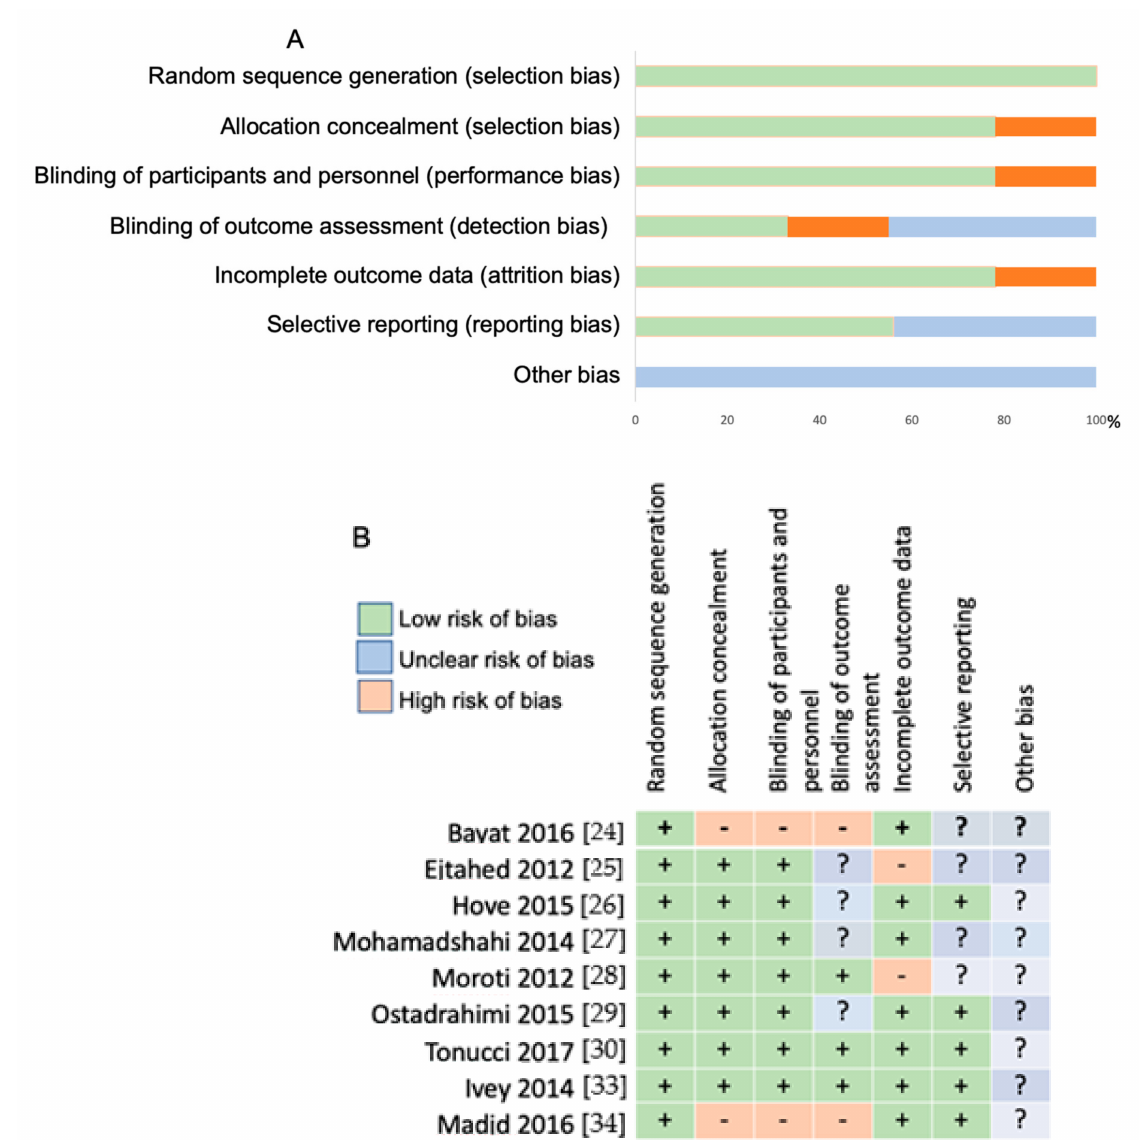
Figure 2. Risk of ( A ) bias graph and ( B ) risk of bias summary in nine